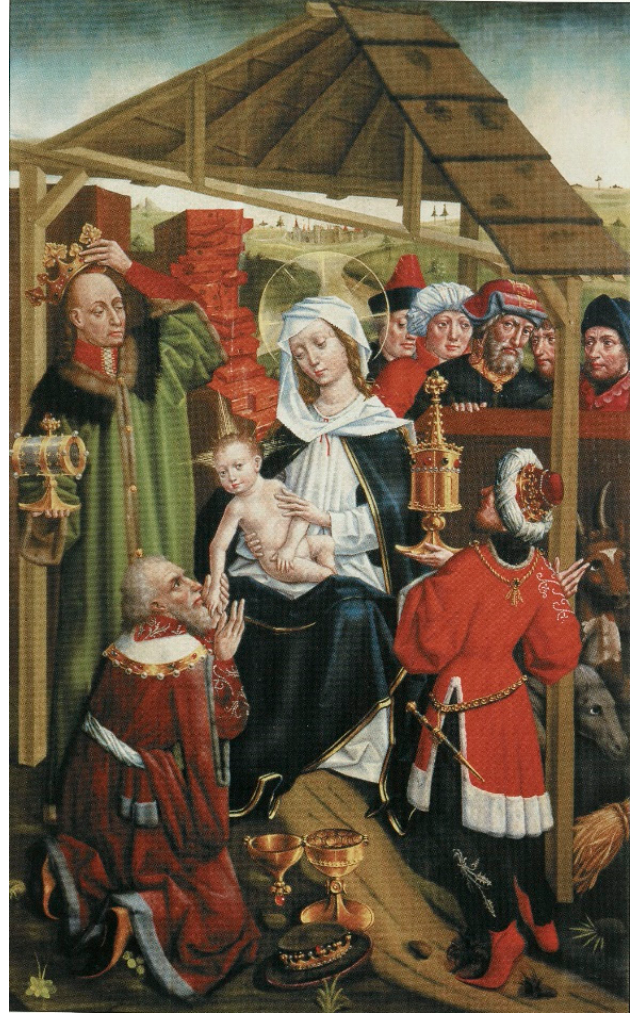
Figure 7. Adoration of the Magi, wing panel of a triptych, tempera on wood, ca. 1475, Cracow, cathedral, Chapel of the Holy Cross, photo published in [37] .